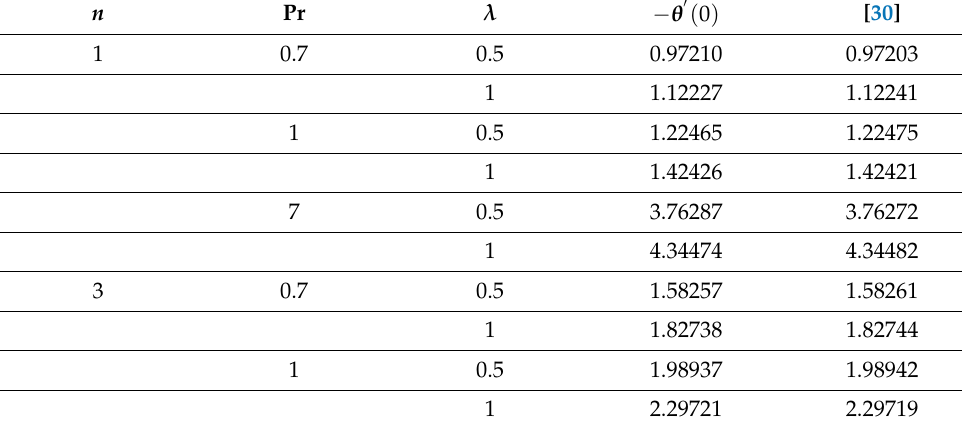
Comparison of the obtained solutions for − θ (cid:48) ( 0 ) with the existing results [30] when N R = ∞ , M = φ = Ec = 0 and Pr =